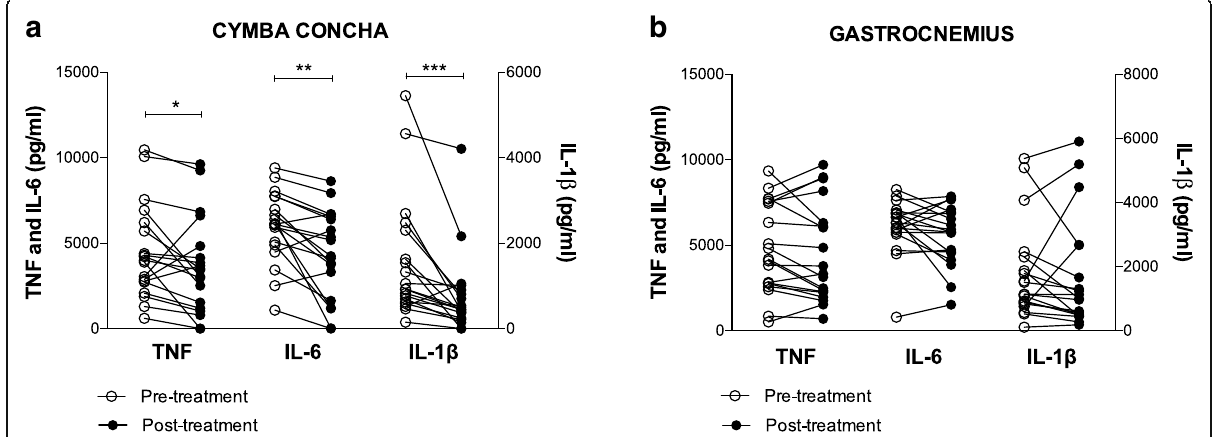
Fig. 4 Vibrotactile stimulation at the cymba concha but not at the gastrocnemius, attenuates inflammatory responses in healthy subjects ex vivo. Nineteen healthy subjects enrolled in a cross-over study at the Feinstein Institute for Medical Research received stimulation at either the cymba concha or gastrocnemius on two different days. Blood was collected 30 min prior and 1 h post stimulation. Whole blood was incubated with LPS, and cytokine levels in plasma were determined 4 h after. ( a ) Effect of vibrotactile stimulation at the cymba concha on cytokine responses in healthy subjects. (TNF * p < 0.05, IL-6 *** p < 0.001, IL-1 β **p < 0.01, Wilcoxon matched-pairs test) ( b ) Effect of vibrotactile stimulation at the gastrocnemius on cytokine responses in healthy subjects. Open circles represent the pre-treatment and close circles represent post-treatment cytokine levels with lines connecting data points for each individual study